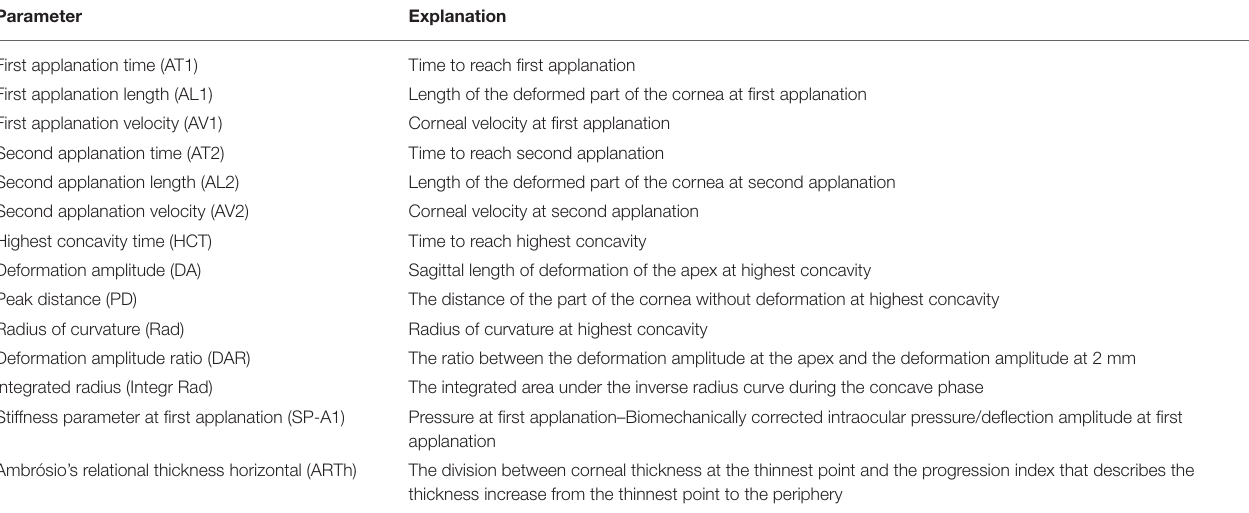
TABLE 2 | The meaning of Corvis ST